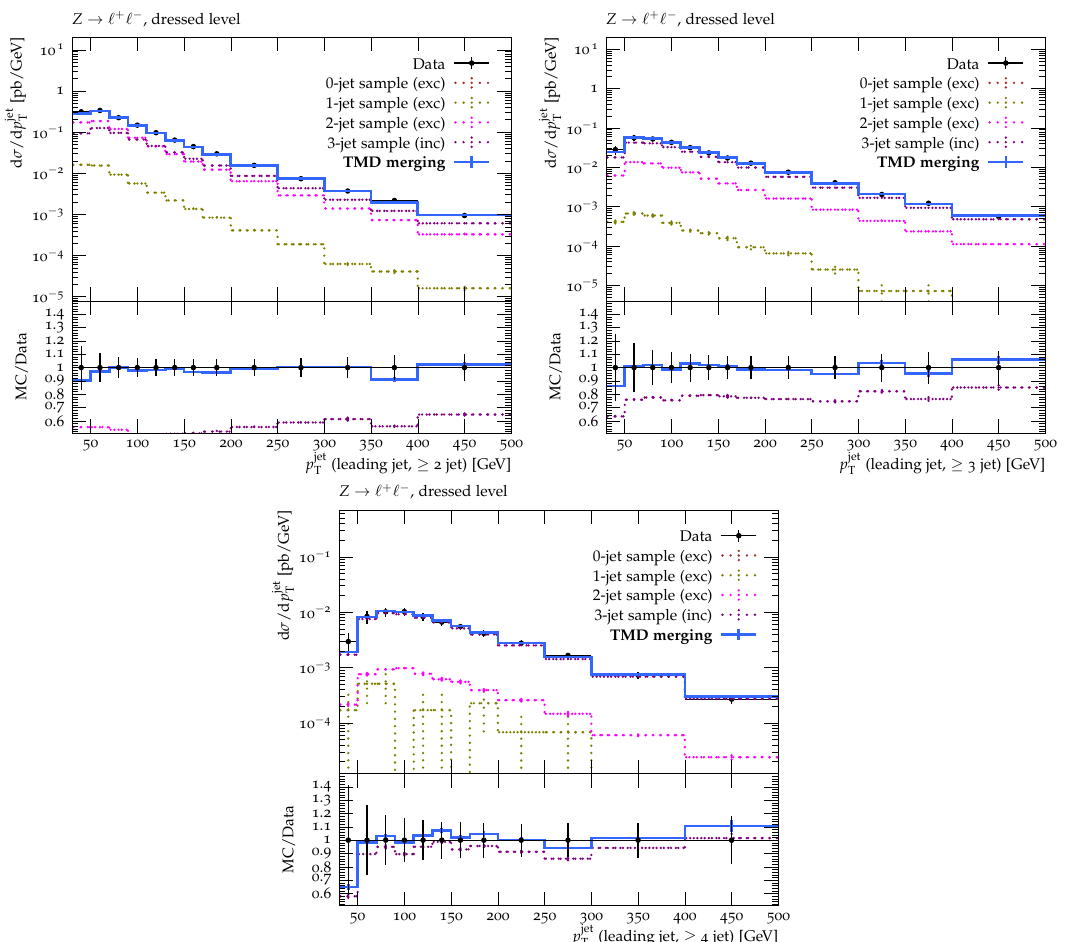
Figure 13 . Leading jet p T spectrum in inclusive Z + 2 (top left), 3 (top right), and 4 (bottom) jets. √ Experimental measurements by ATLAS [91] at s = 13 TeV are compared to predictions using the TMD merging calculation. Separate contributions from the different jet samples are shown. All the jet multiplicities are obtained in exclusive (exc) mode except for the highest multiplicity which is calculated in inclusive (inc)